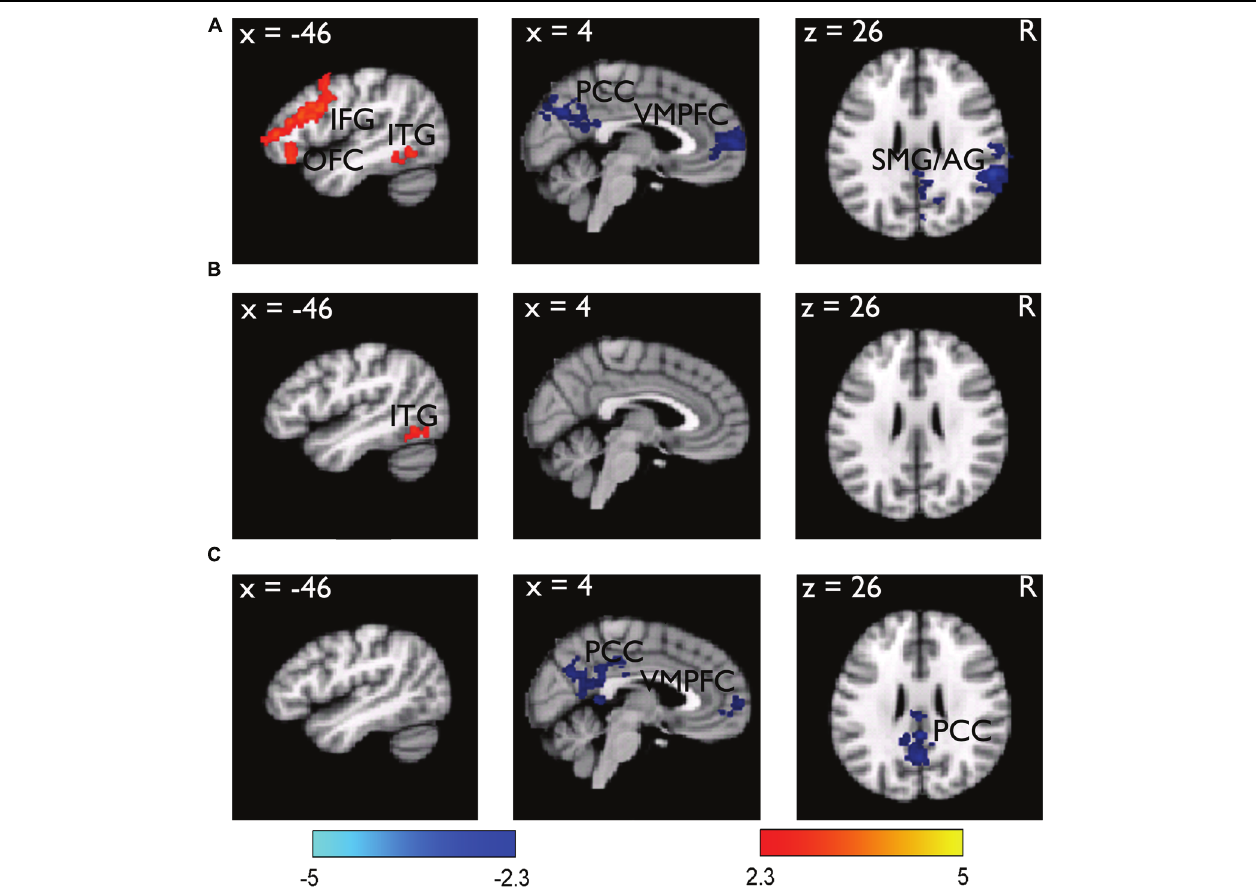
FIGURE 2 | Brain regions related to the subsequent memory effect. (A) Brain regions showing stronger (red-yellow color) and weaker (blue color) activity during learning/encoding for subsequently remembered than forgotten LRN items. The results are overlain on the sagittal and axial slices of the group mean structural image. All activations were thresholded at Z > 2.3 (whole-brain corrected p < 0.05). (B) The subsequent memory effect obtained from the LRN + JOL trials, showed an overall reduction. (C) Direct comparison of the subsequent memory effect between the LRN and LRN + JOL trials revealed stronger deactivation for the LRN